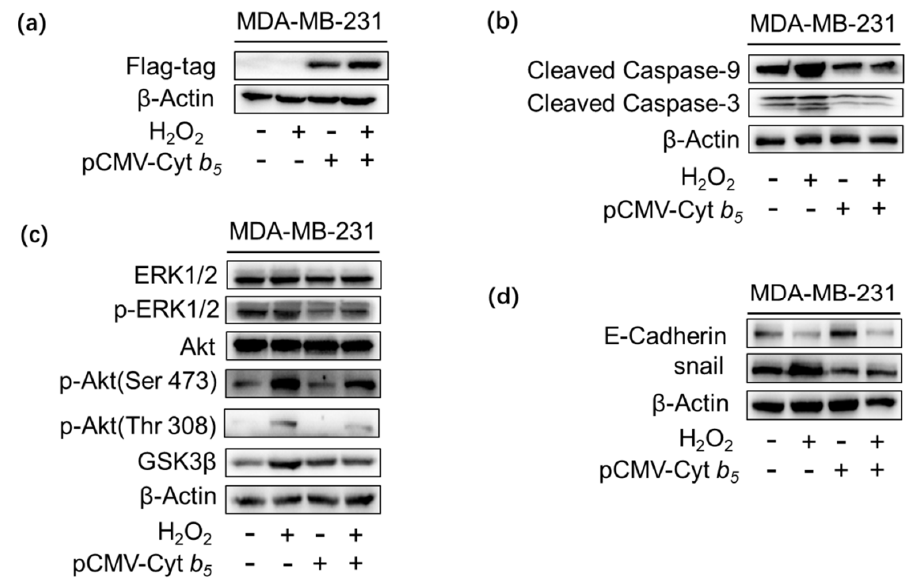
Figure 4. Effects of overexpression of Cyt b 5 on cell signaling pathways. ( a ) Significant expression of Flag-tag in MDA-MB-231 cells, as verified by western blot analysis. ( b – d ) Changes in apoptosis- related proteins ( b ), ERK1/2 and Akt signaling pathways ( c ), and snail/E-Cadherin signaling pathway ( d ), in MDA-MB-231 cells by western blot analysis.